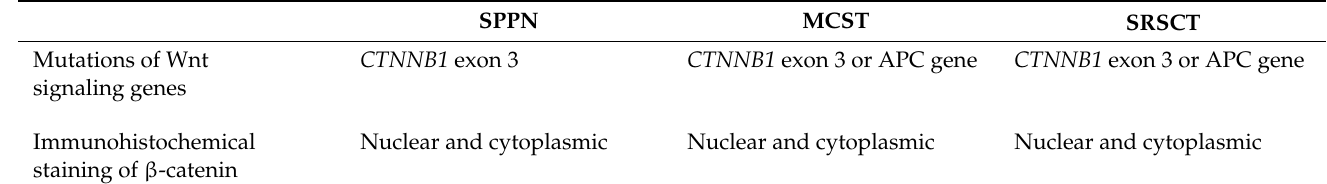
Table 1. Cont. SPPN MCST SRSCT CTNNB1 exon